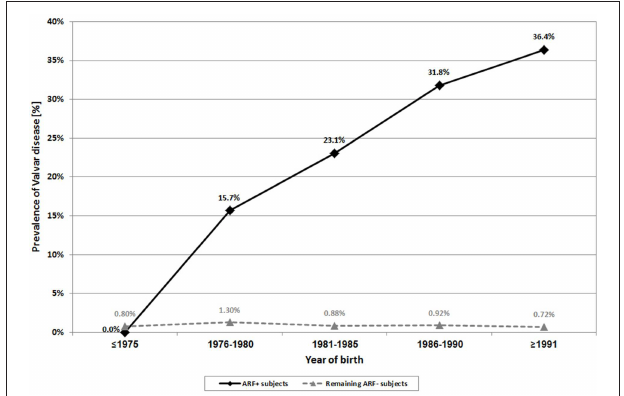
FIGURE 2 | Secular trends of valvar disease prevalence among ARF + subjects and among the remaining ARF– subjects.